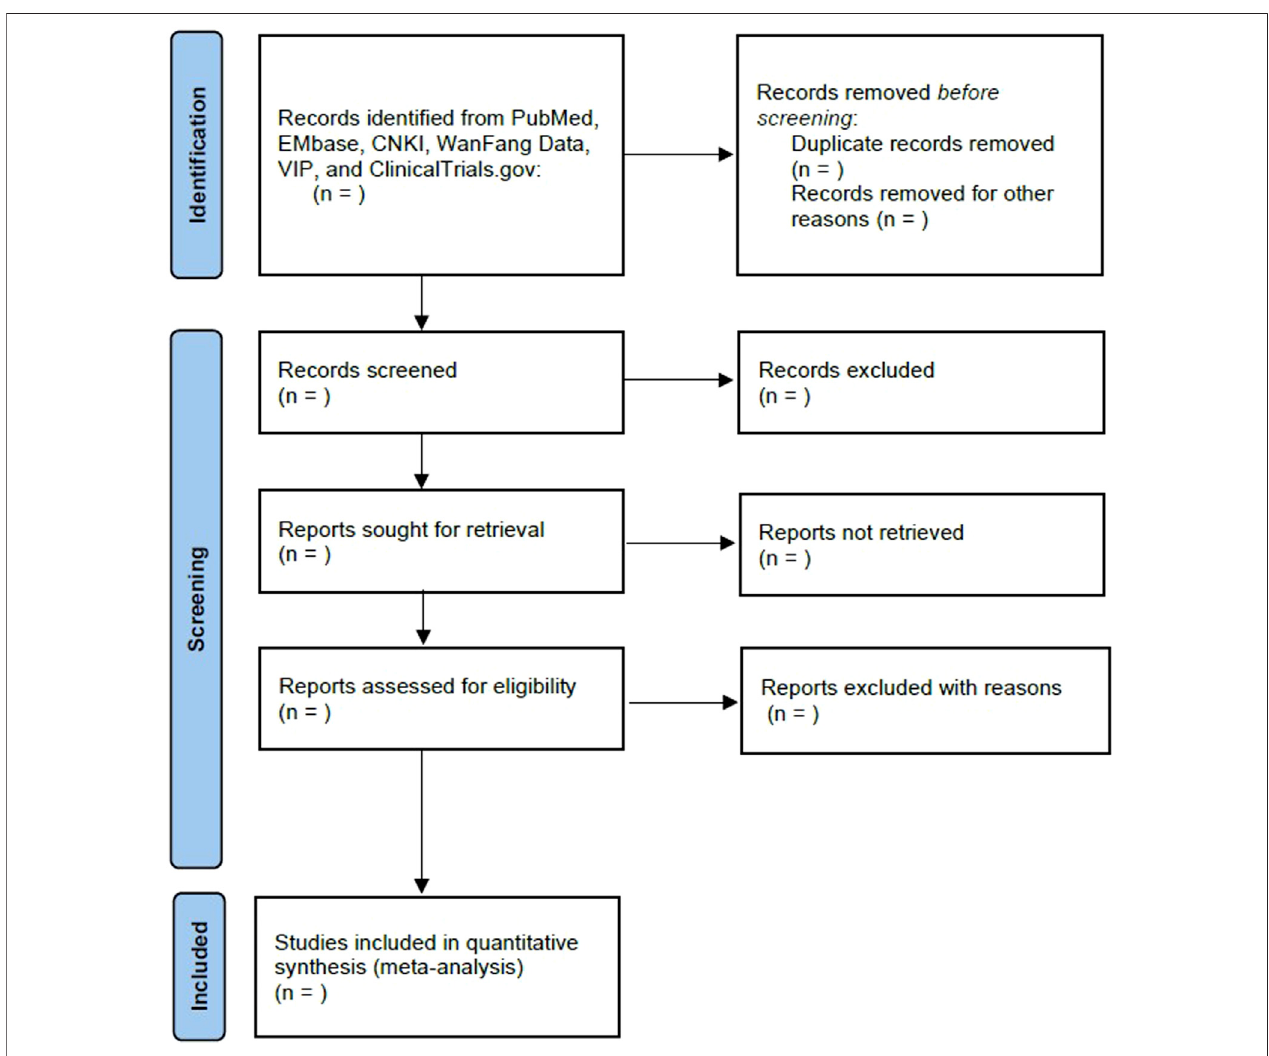
FIGURE 1 | Flow diagram of the study selection